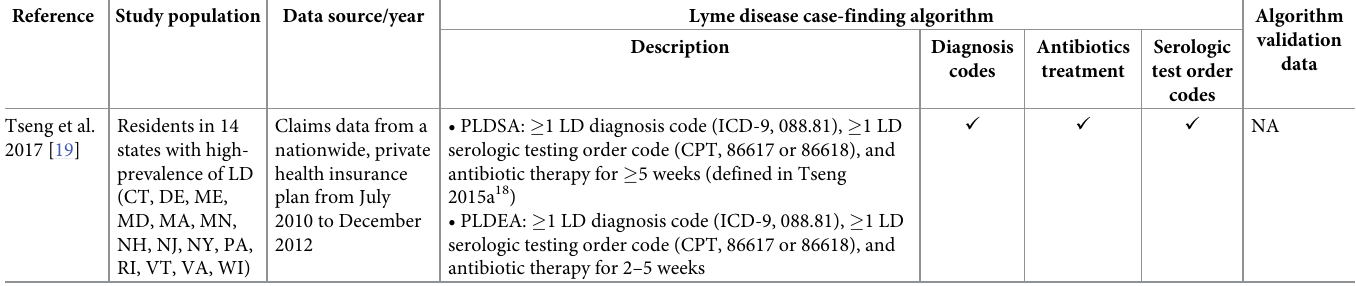
S1 Table. PRISMA checklist.